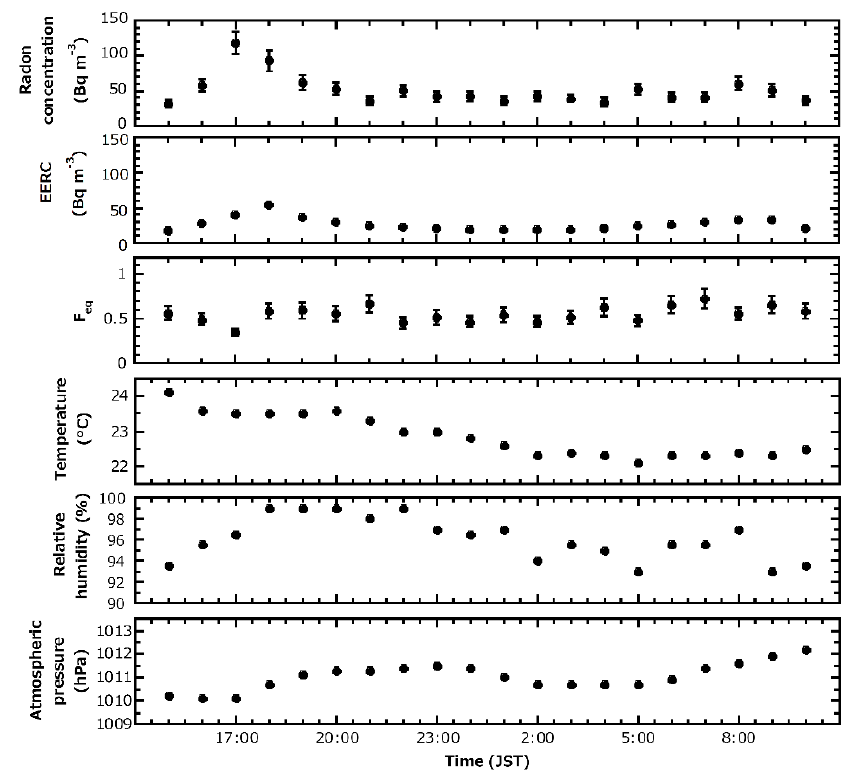
Figure 5. Measurement results in winter.